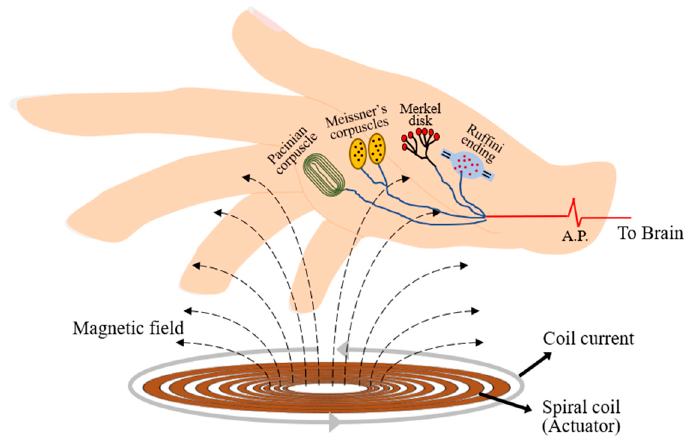
Figure 2. Schematic of the diagram for tactile sensation induced by TSTM (A.P. refers to action potential).